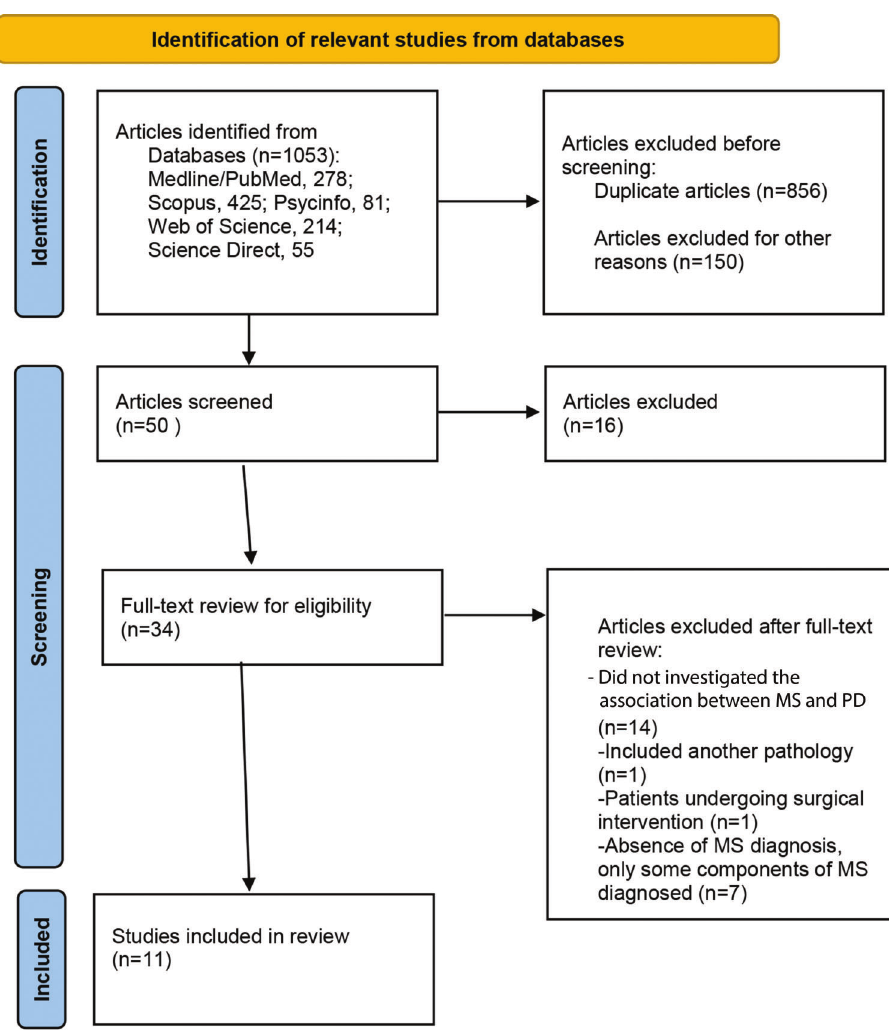
Figure 1 - Flowchart of study